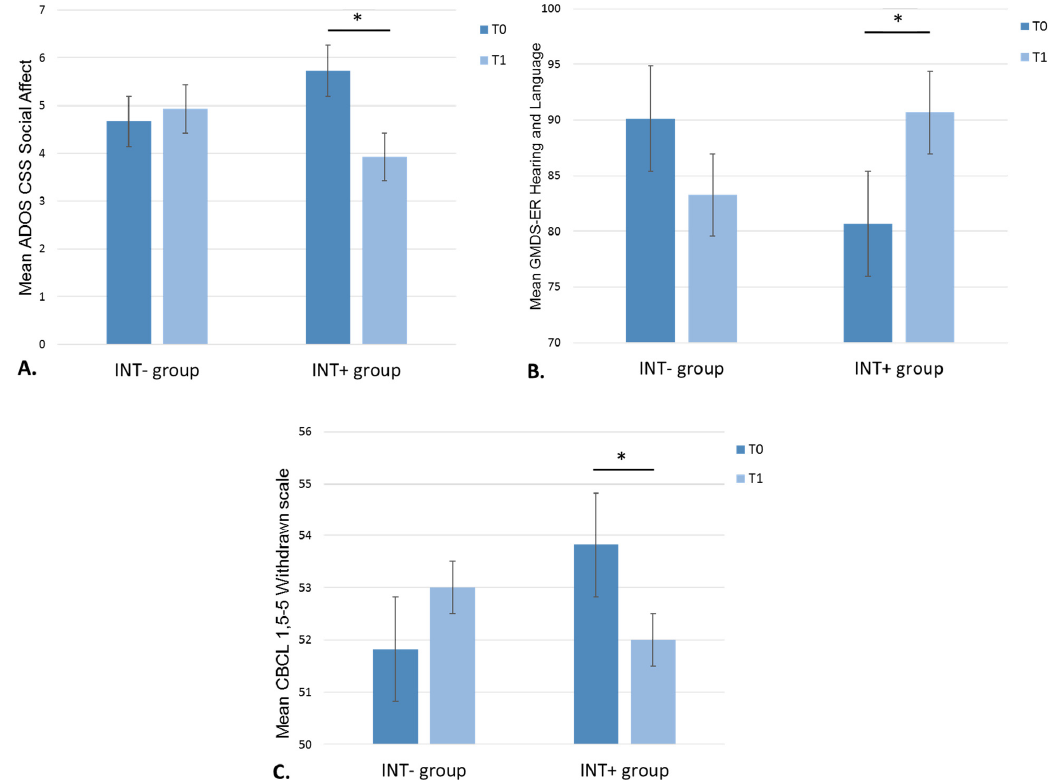
Figure 2. Graphical representation of mean standardized scores for ADOS CSS Social Affect ( A ), GMDS-ER Hearing and Language ( B ), and CBCL Withdrawn scale ( C ) at T0 and T1 in the two groups. Legend. Error bars show the 95% CI around each mean. Asterisks (*) indicate significant differences. INT − , group without intervention; INT+, group with intervention; CSS, Calibrated Severity Scores; GMDS-ER, Griffiths Mental Development Scales—Extended Revised 0–2; CBCL, Child Behavior